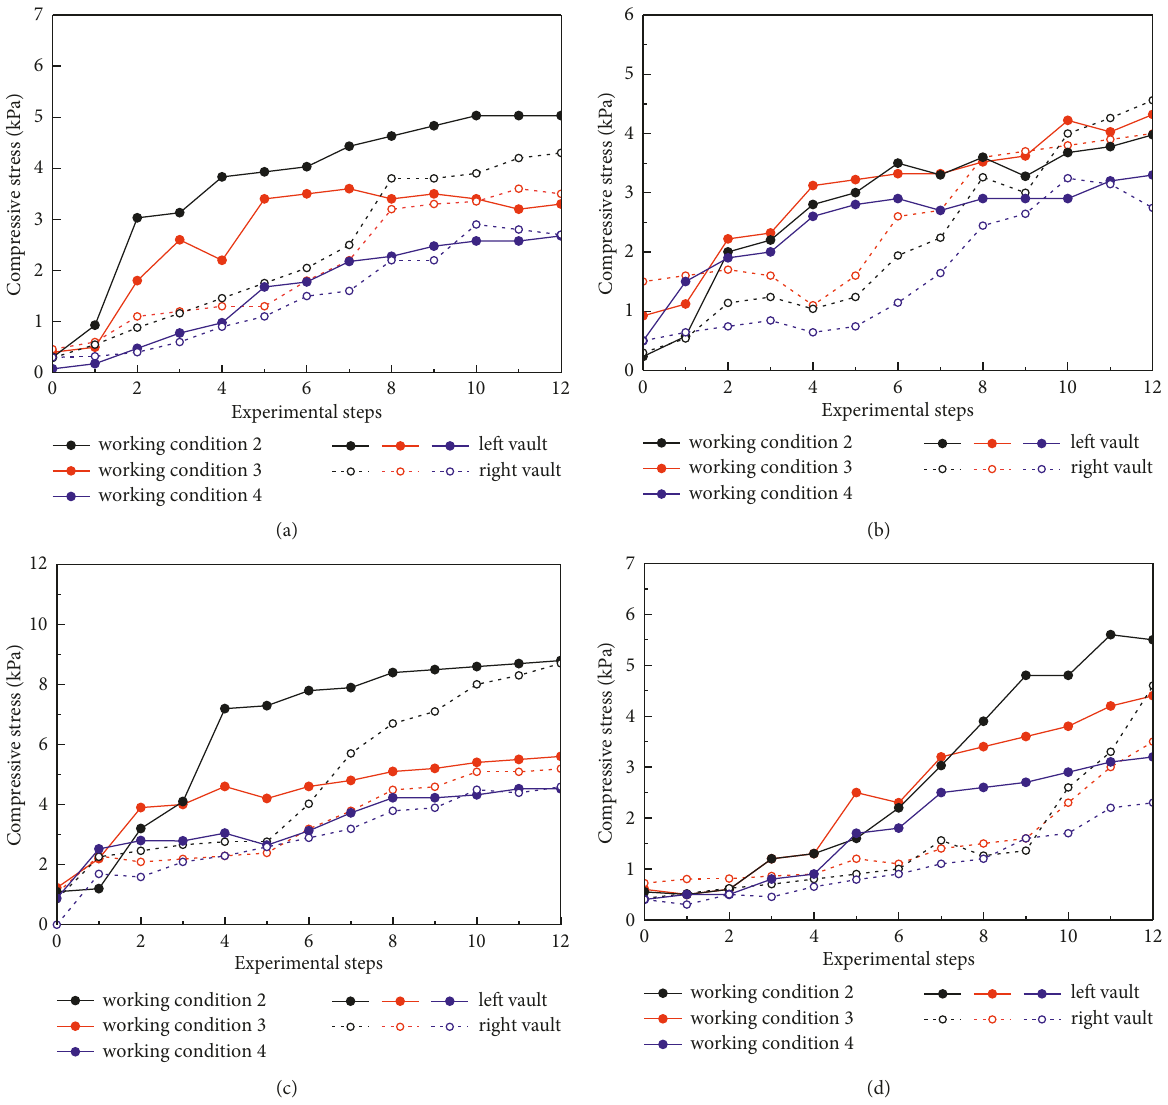
Figure 11: Lining stress variation of different positions under different pre-reinforcement measures. Lining stress variation at (a)vault position, (b) arch shoulder position, (c) arch foot position, and (d) arch bottom position.